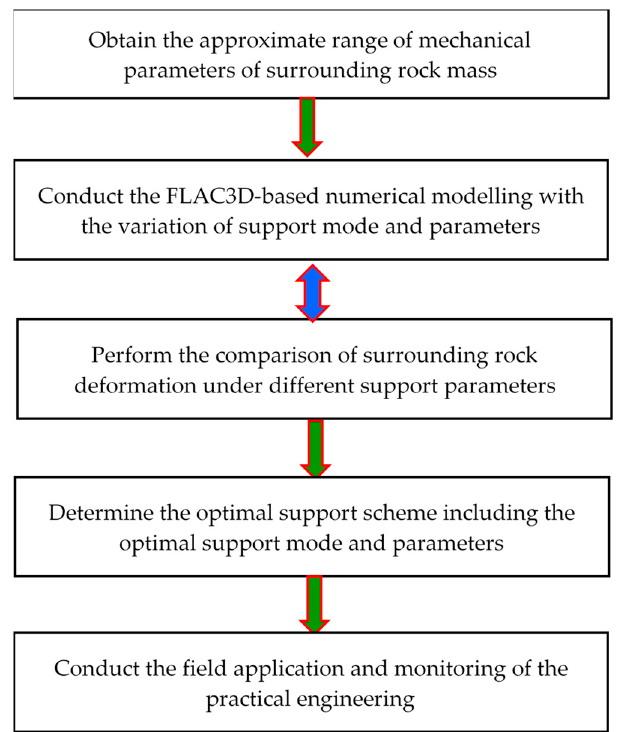
Figure 3. The optimization process of roadway support mode and parameters.